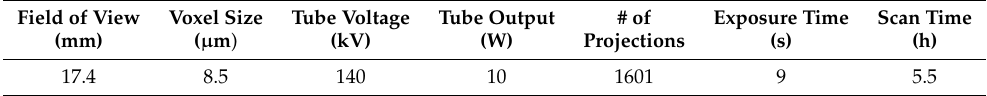
Table 2. Settings used for XCT